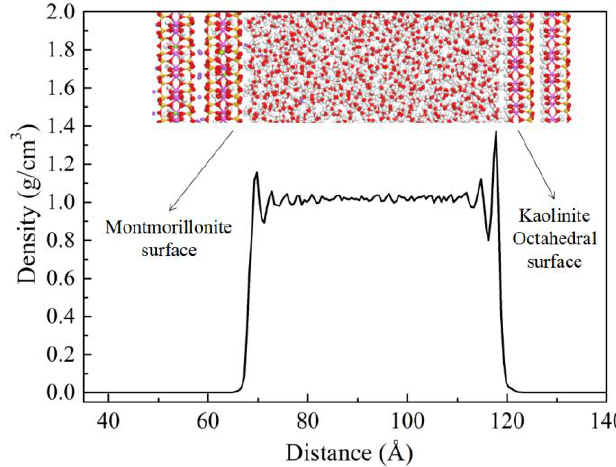
Figure 16. Density distribution of water on the surface of montmorillonite and the octahedron surface of kaolinite.